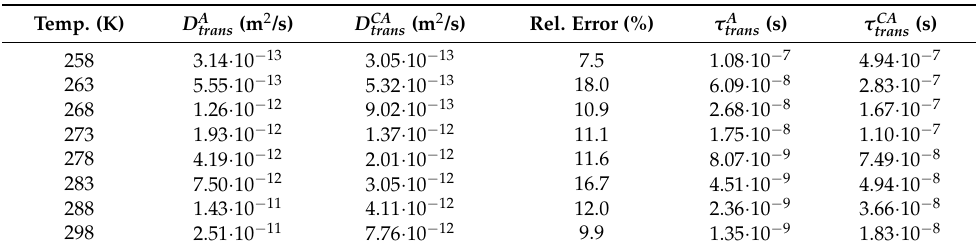
Table 2. Parameters characterising the translational and rotational dynamics of TEA-C4 anion